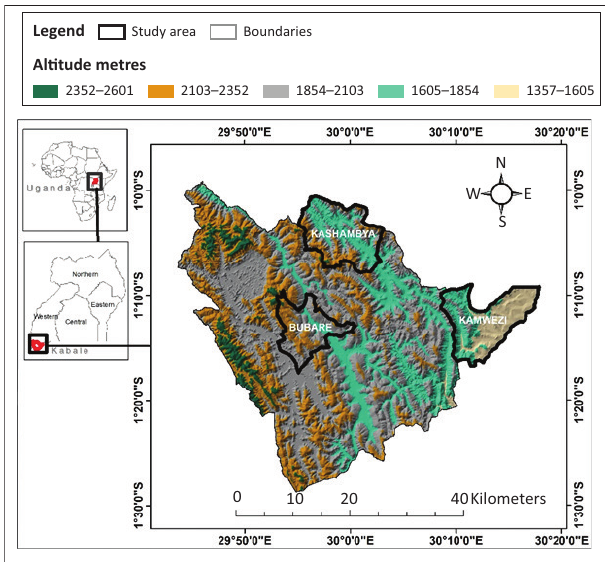
FIGURE 1: Location of the study